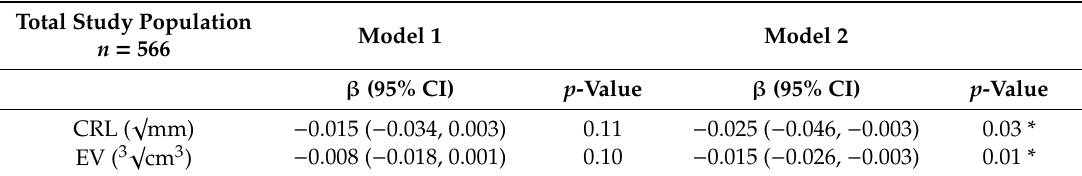
Table 3. Associations between neighbourhood status score (NSS) and embryonic growth trajectories, expressed as longitudinal crown–rump length (CRL) and embryonic volume (EV) measurements in the total study